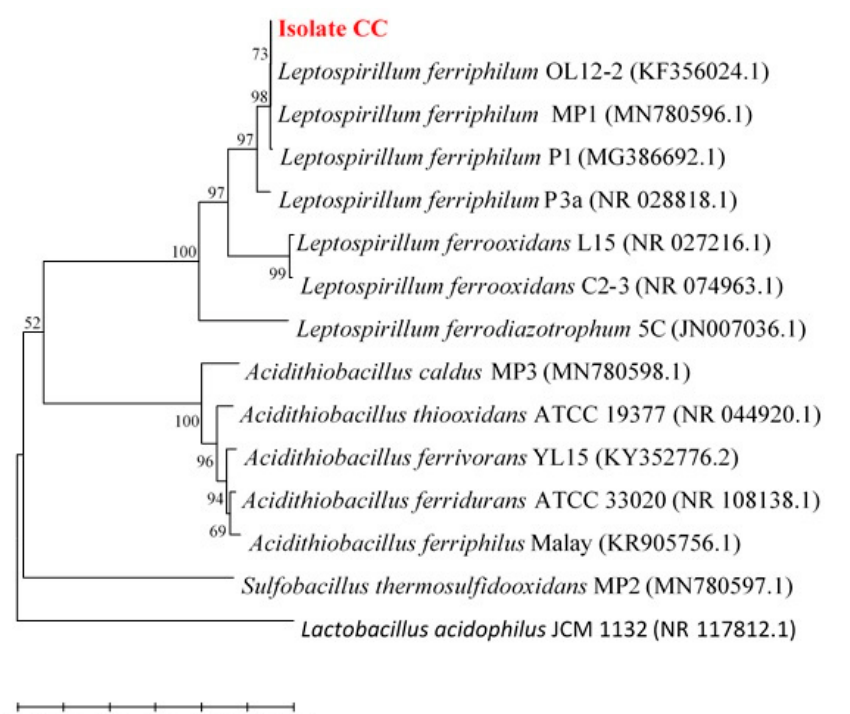
Figure 3. Phylogenetic position of strain CC. The evolutionary history was inferred using the neighbor-joining method [46]. The percentage of replicate trees in which the associated taxa clustered together in the bootstrap test (10,000 replicates) are shown next to the branches [47]. Table 2. Identity of 16S rRNA of isolated Leptospirillum sp. CC with other L. ferriphilum strains.